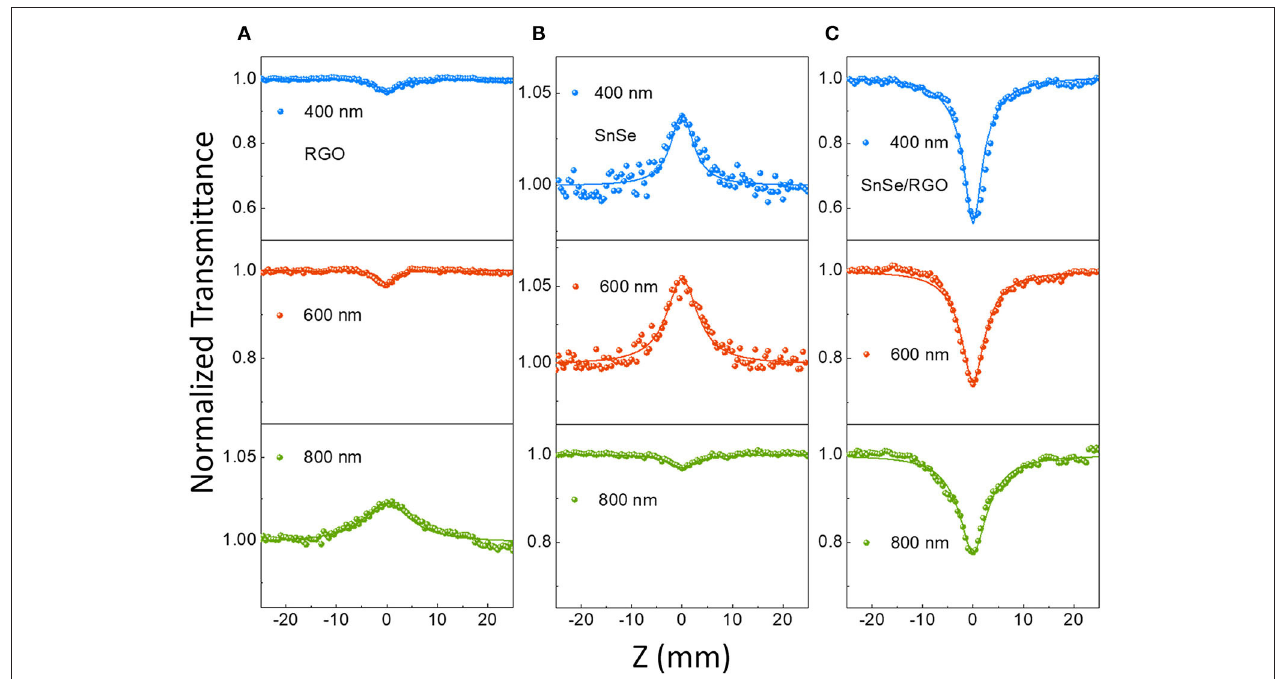
FIGURE 2 | OA Z-scan results of (A) RGO, (B) SnSe, and (C) SnSe/RGO with different excitation wavelengths of 400, 600, and 800nm.